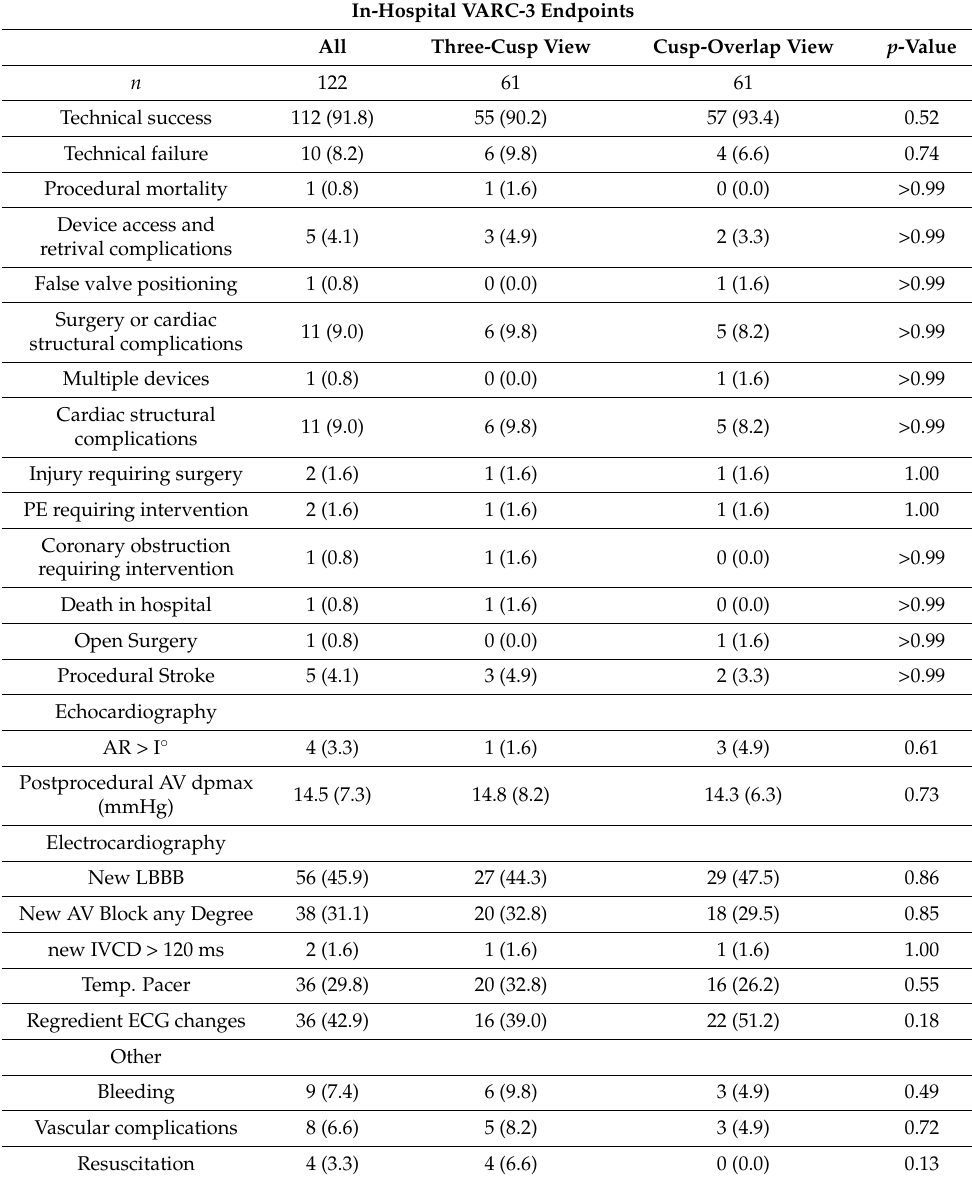
Table 3. In-hospital VARC-3 endpoints. This shows procedural endpoints in COP and TCV